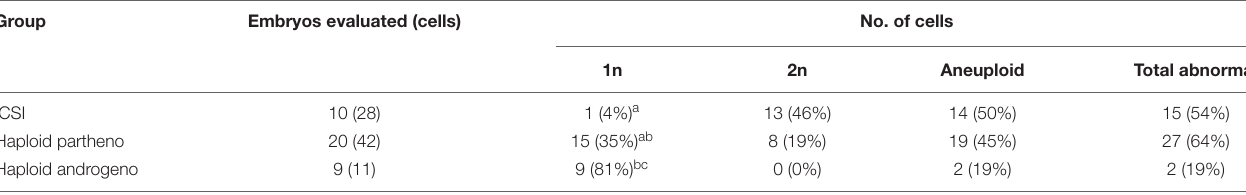
1n 2n Aneuploid Total abnormal